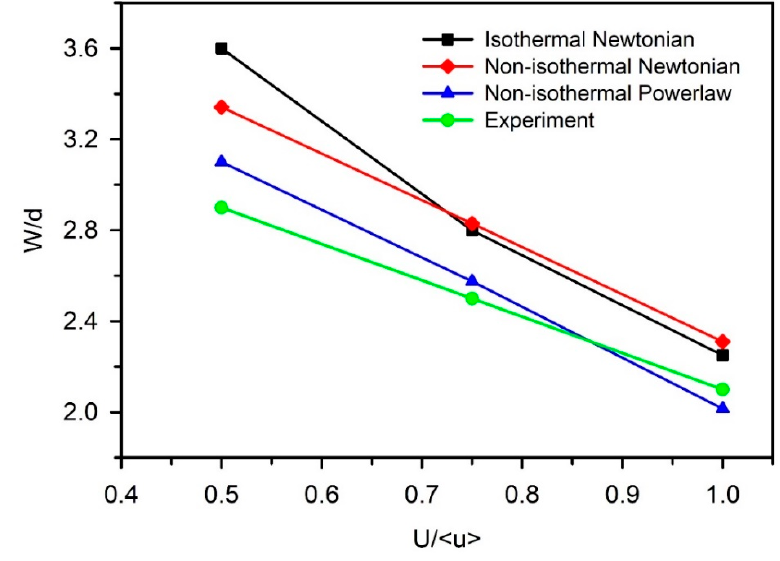
Figure 10. Comparison of W / d vs. U /< u > for g / d = 0.4 obtained from simulations and the experiment. (Lines connecting symbols are for visual guidance).